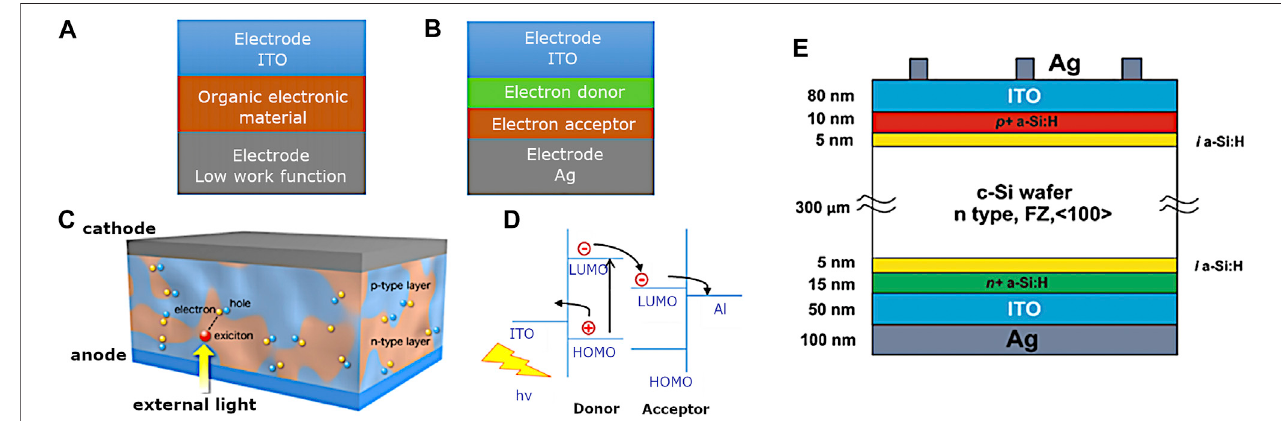
FIGURE 3 | Schematic representation of (A) OPV photovoltaics, (B) heterojunction or bilayer photovoltaics, (C) bulk heterojunction photovoltaics (Organic Solar Cell(OSC)|ChihayaAdachilab), (D) electron-holemovementinsidetheenergylevelsofthephotovoltaicsmaterials,and (E) schematicdiagramofasiliconheterojunction solar